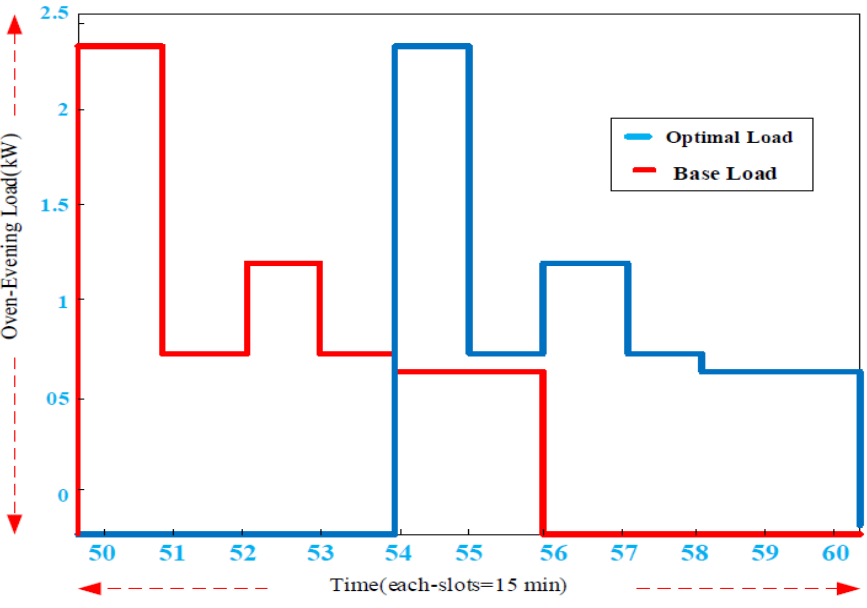
Figure 14. Oven consumption profile in the morning.